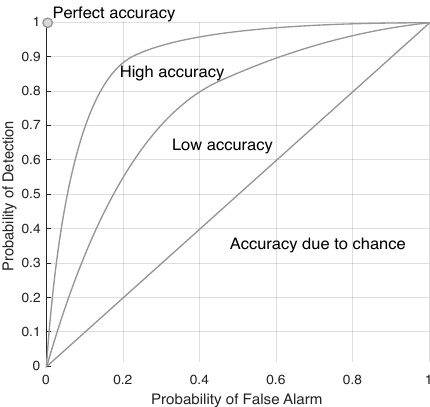
Figure 2. Illustrating the implication of the receiver operating characteristics (ROC) in target